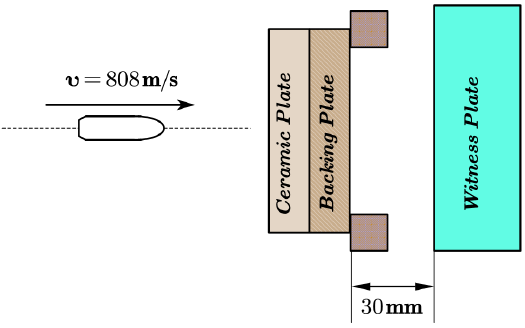
Figure 2. Bullet experiment device.